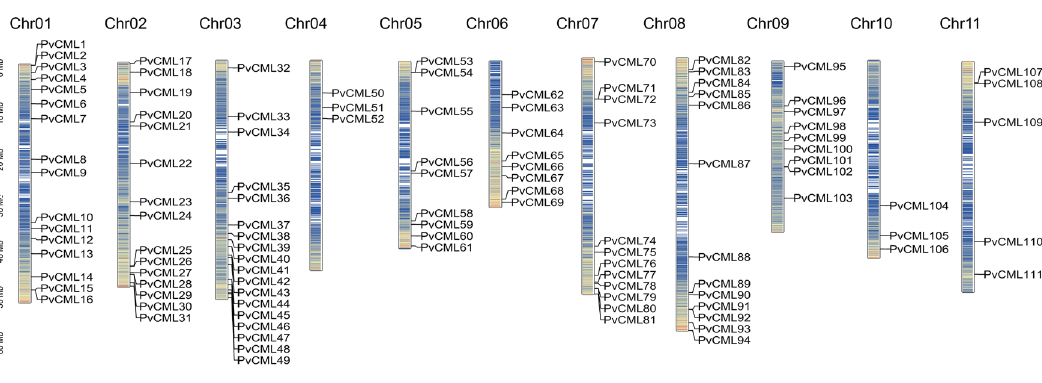
Figure 1. Distributions of PvCML genes on the P. vulgaris chromosomes. Chromosome numbers are located at the top of each bar. Sizes of chromosomes are represented by the vertical scale. The scale is in megabases